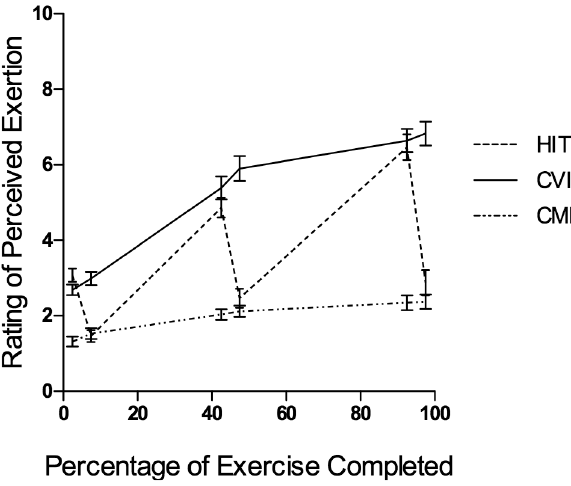
Figure 1. Rating of perceived exertion (M ¡ SE) during the three exercise